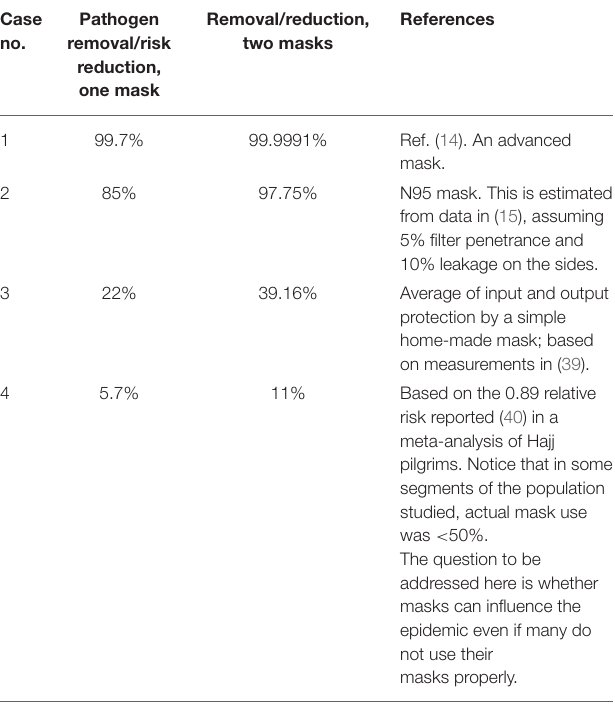
TABLE 1 | Four cases representing four different levels of protection by mask that have been considered in this study and incorporated into the simulations that use COVID-19